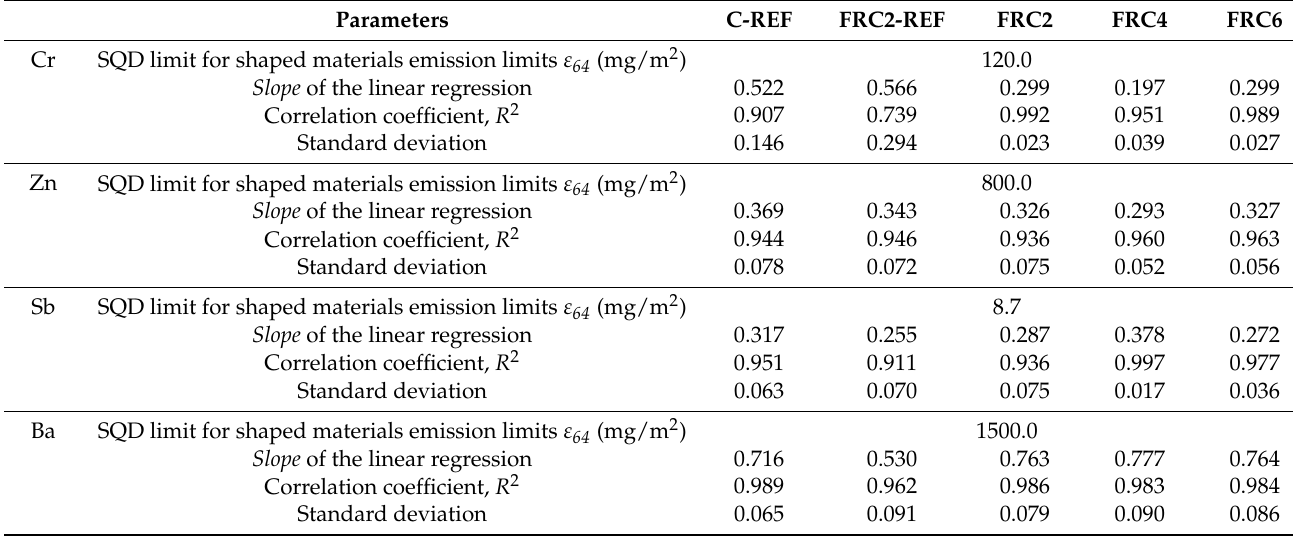
Table 5. Limits for diffusion release levels from shaped construction materials (in mg/m 2 ). Slope of linear regression and correlation